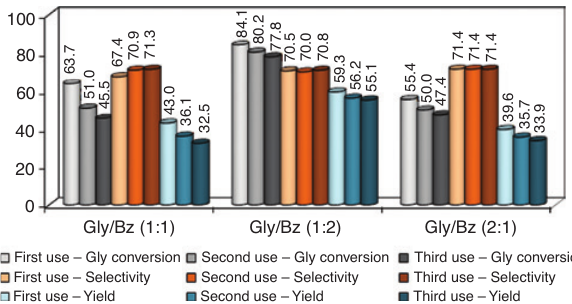
Figure 7: Catalyst reuse experiments stats (%) versus glycerol/ benzaldehyde comparison ratios. Glycerol conversion in shades of gray, cyclic acetals selectivity in shades of red and reaction yield in shades of blue. Errors deviation in